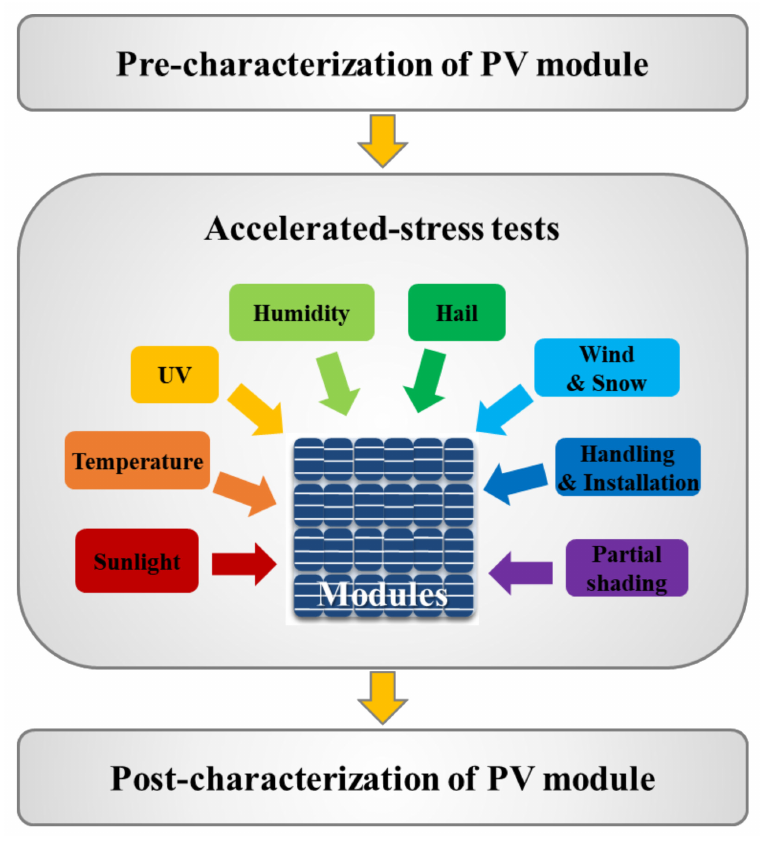
Figure 2. Conceptual representation of the AT of PV